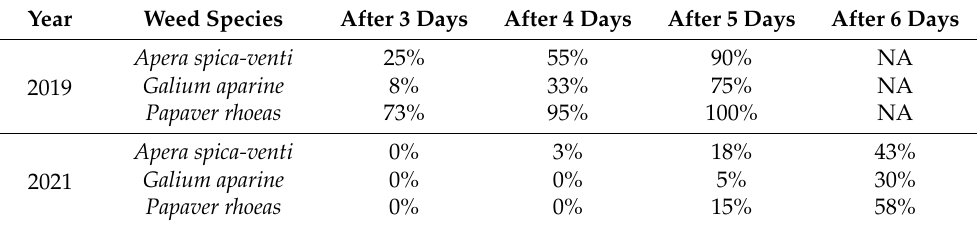
Table 1. Percentages of weed seed cards with 100% consumption after 3 to 6 days of exposure to seed predation inside the winter wheat field and in the adjacent SNH in 2019 and 2021, Gödöll˝o, Hungary.